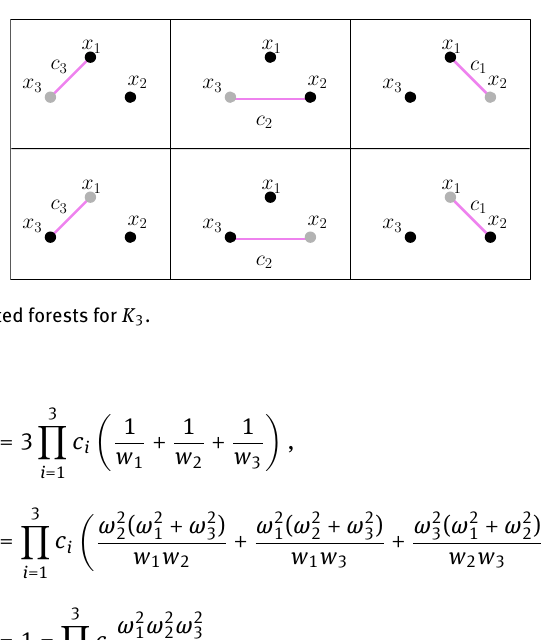
Figure 7: The network K 3 (left) and the collection of spanning trees for K 3 (right).